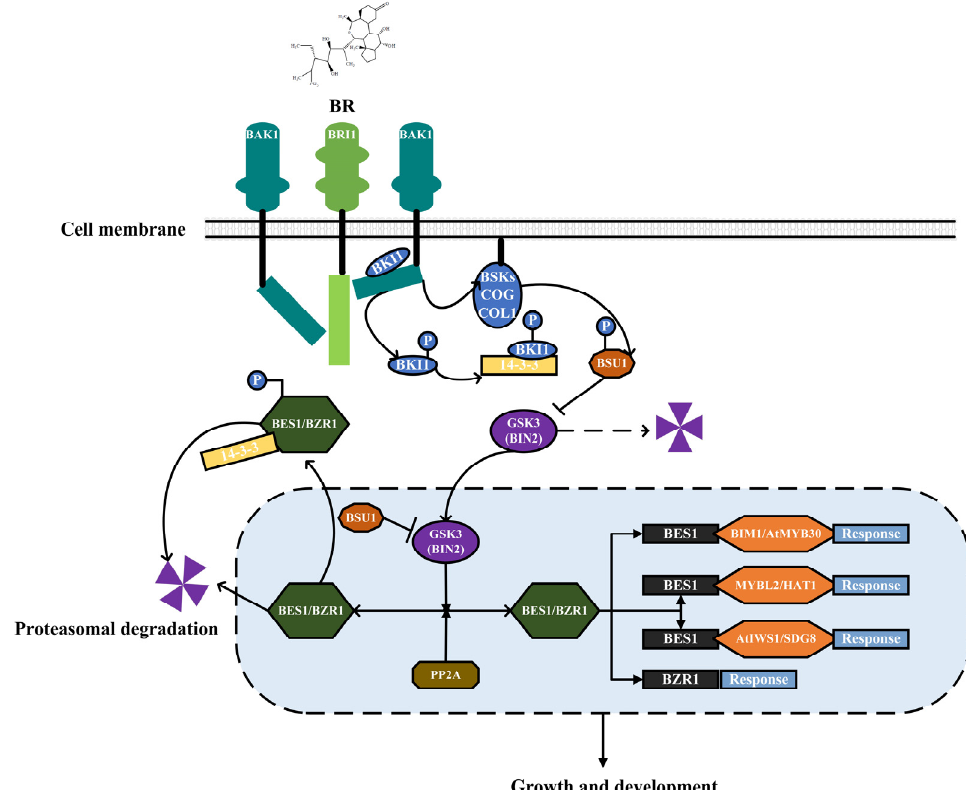
Figure 2. The signal transduction of BR. The cylinder (BAK1; BRI1), the circle (BKI1; BSKs/COG/COL1; GSK3; BIN2), lozenge (BSU1; BES1/BZR1; PP2A; BIM1/AtMYB30; MYBL2/HAT1; AtIWS1/SDG8), and rectangle (14-3-3; BES1) denoted the receptor proteins or signal molecules involved in signal transduction. ( → ) indicated the promoting effect, ( ⟞ ) indicated the inhibiting effect.